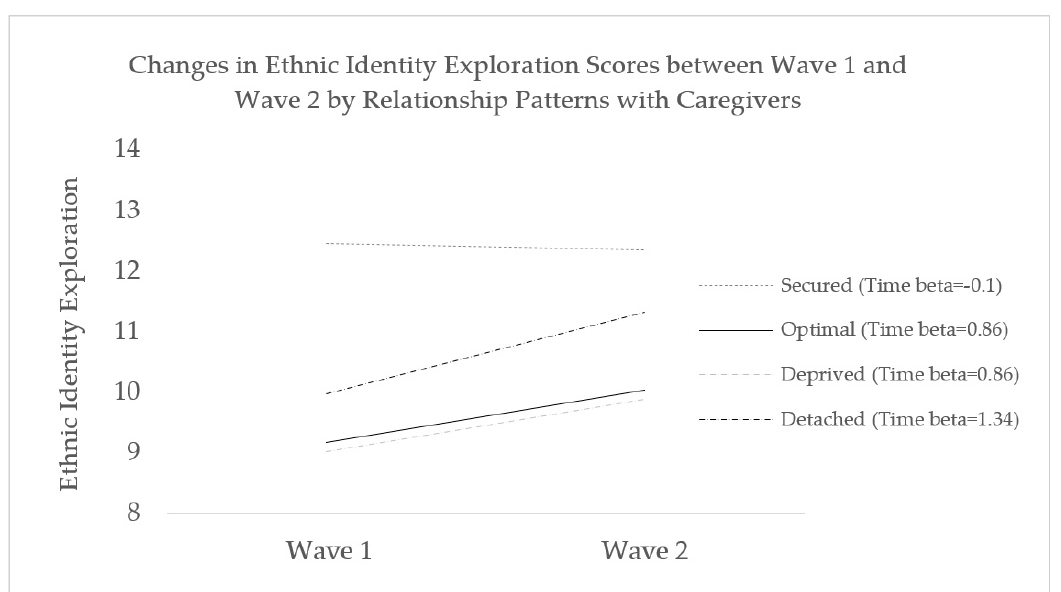
Figure 3. Interaction effects of time and relationship patterns with caregivers on ethnic identity exploration.